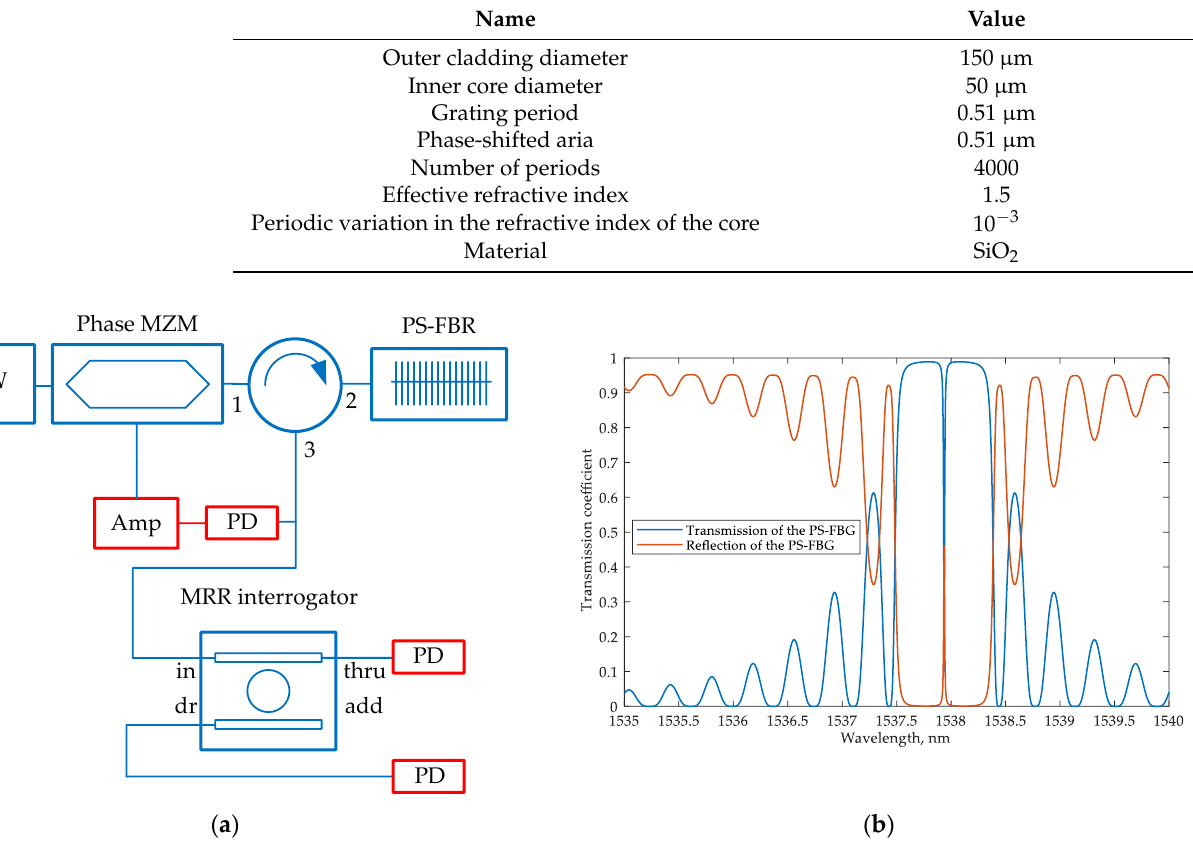
Figure 17. ( a ) PS-FBG interrogation scheme with an OEO; ( b ) PS-FBG transmission and reflection signals spectra at the resonant wavelength λ B = 1537.2 nm. Numbers 1 – 3 denote the order of the circulator ’ s ports.